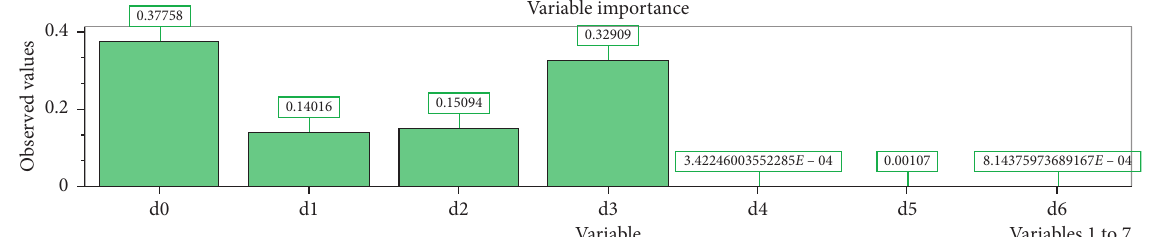
Figure 4: CBR variable importance of observed values and the input variable; (d0) HARHA; (d1) w (d6) δ max .